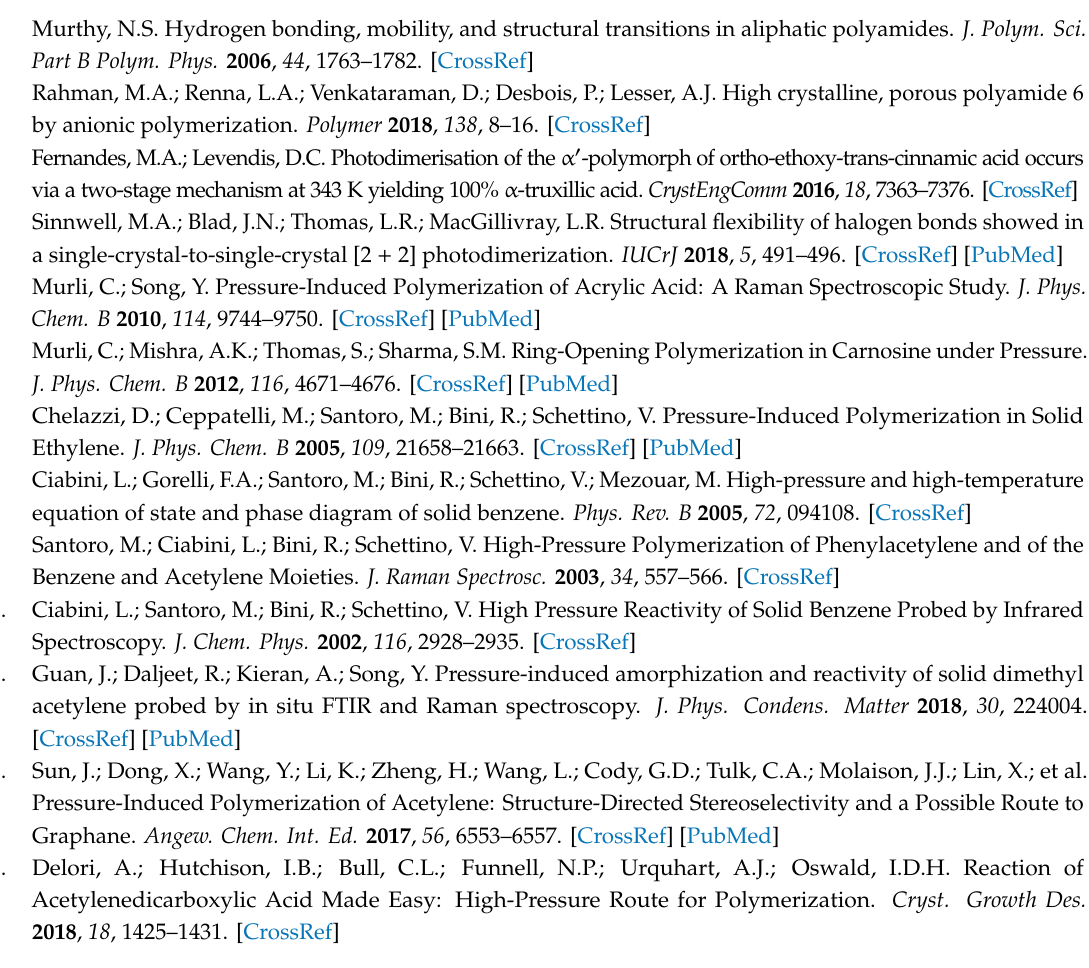
medium, Figure S4: (a) The Pawley fit of the data at 2 tonnes on decompression (0.53 GPa) using the cell parameters of Form III of caprolactam; (b) the di ff raction patterns of caprolactam on decompression from 5.69 GPa, Figure S5: Void space using 0.5 Å probe radius and 0.2 grid spacing for (a) Form II at 1.2 GPa and (b) Form III at 0.94 GPa. The percentage of void space in Form II was 4% of unit cell volume compared with 1.5% for Form III, Figure S6: The molecular volume of each form as a function of pressure. The two loadings are color coded black (Loading 1; crystal from ethyl acetate) and red (Loading 2; crystal from ethanol- d 6 ). Hollow symbols represent Form I and solid symbols represent Forms II and III. Form III is consistently denser over the entire compression range, Figure S7: Rietveld fit of the 5.4 GPa data to Form III. The peak at 4.1 Å is due to the sample. The model used was taken from the geometry optimized structure and the orientation allowed to refine whilst keeping conformation of the molecule fixed, Table S1: Crystallographic details for the X-ray determined structures, Table S2: The unit cell parameters of caprolactam- d 10 on compression derived from neutron powder di ff raction data collected on the Pearl